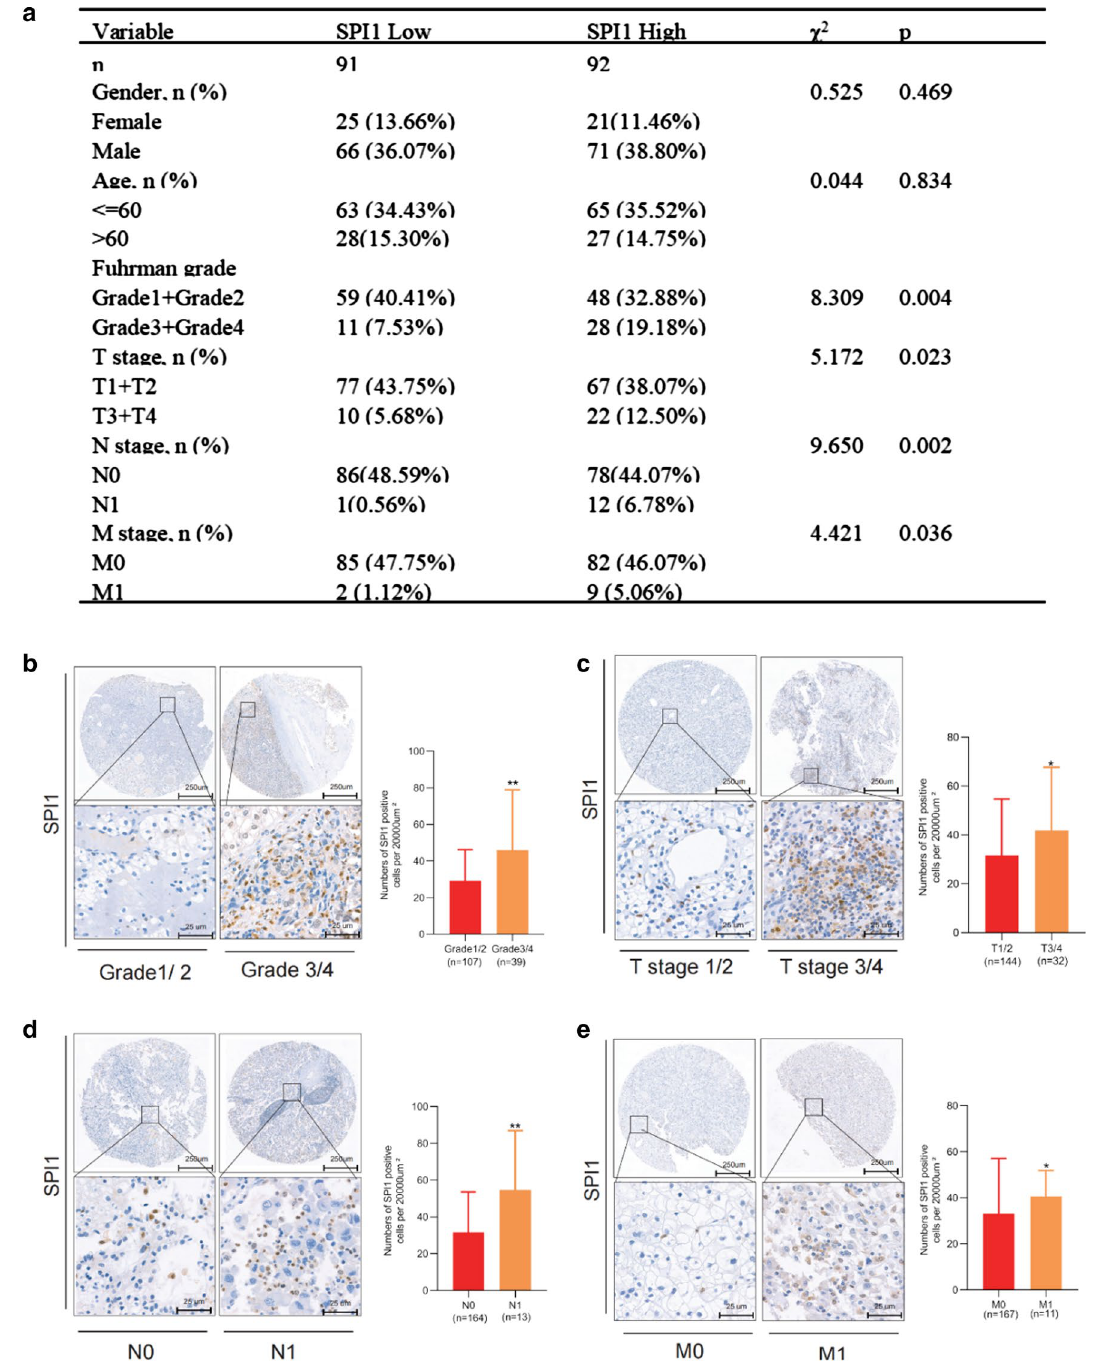
Fig. 2 Relationship between SPI1 expression and clinicopathological parameters in ccRCC. a Clinicopathological parameters correlated with SPI1 expression. b – e High SPI1 expression level was associated with high Furman grade ( b ), T stage ( c ), positive nodal status ( d ), and metas- tasis status ( e ). ccRCC, clear cell renal cell carcinoma; *, p < 0.05; **, p < 0.01; ***, p <